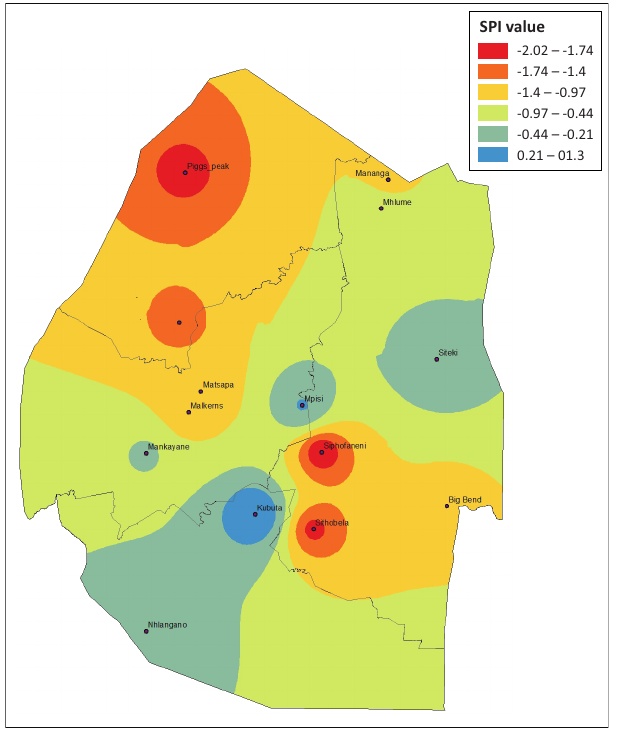
FIGURE 7: Standard Precipitation Index 3-month timescale during 2004–2005.